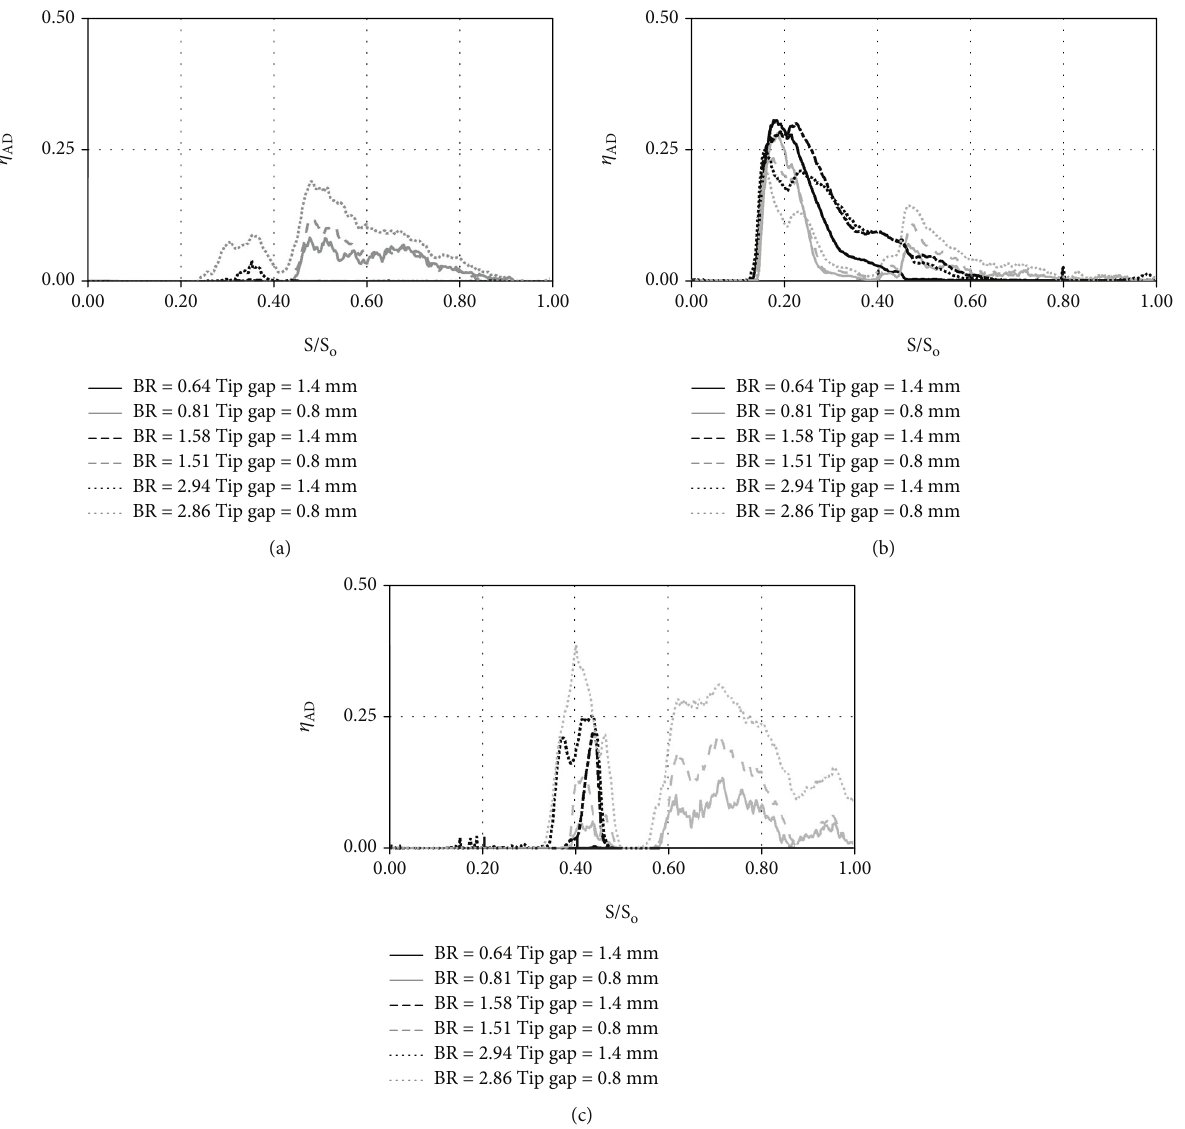
Figure 11: Line-averaged adiabatic fi lm cooling e ff ectiveness along for A1 blade fi lm cooling for di ff erent blowing ratios and tip gaps. (a) Along the pressure side rim. (b) Along the squealer recess region. (c) Along the suction side